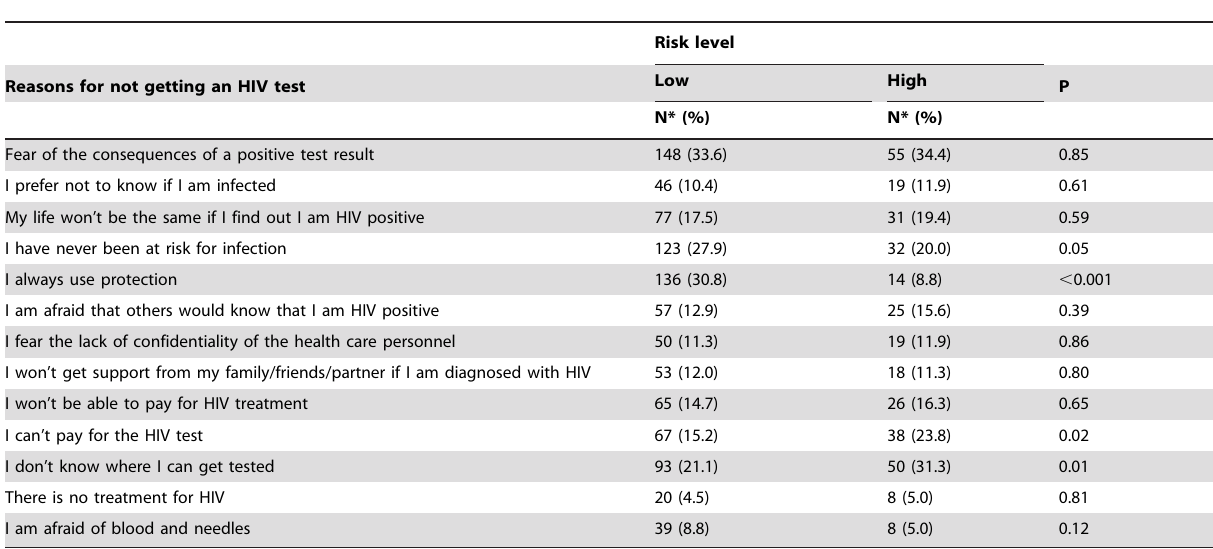
Table 3. Comparison of the main reasons for not getting tested for HIV among MSM who had not tested for HIV within the last year, stratified by level of risk